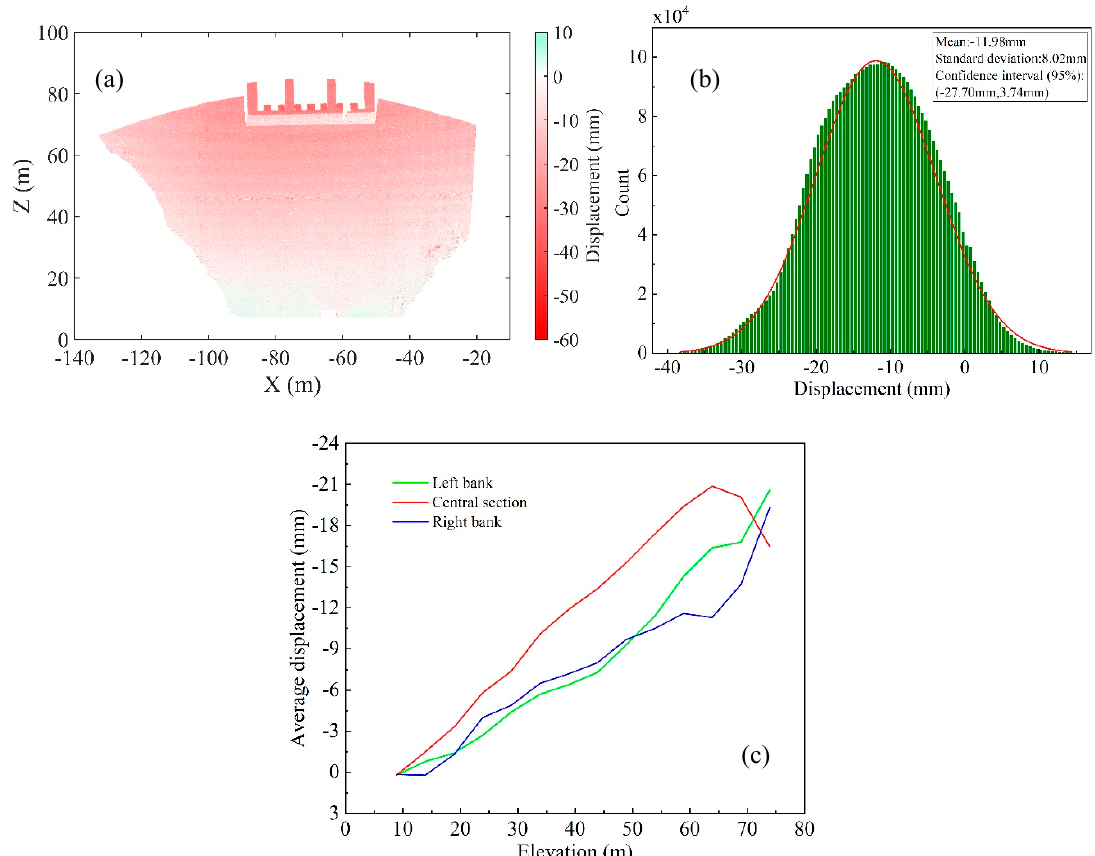
Figure 9. Results of dam displacement variation by contour curve model to model. ( a ) Cloud map of dam displacement variation distribution; ( b ) statistical histogram of displacement changes; and ( c ) average displacement changes of different parts of the dam with different elevations.